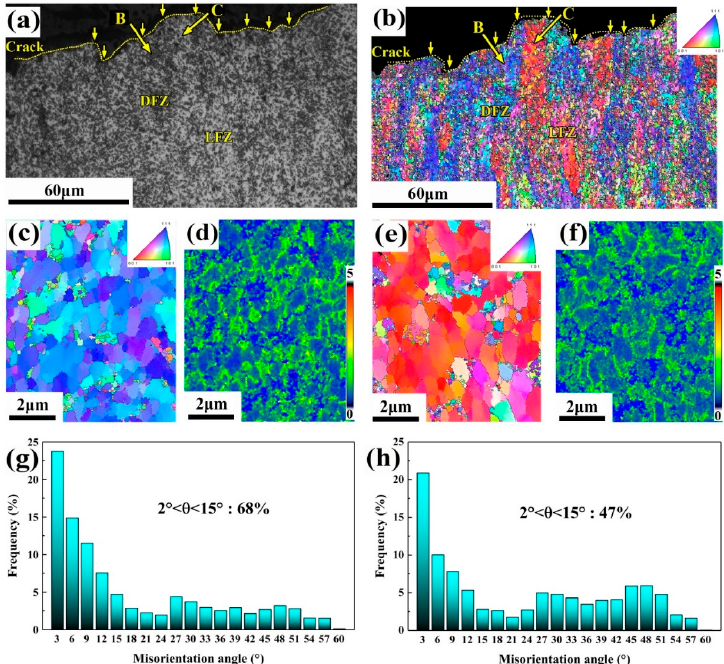
Figure 11. The OM and EBSD results of the selected region: ( a ) the OM image; ( b ) the IPF image; the detailed IPF at ( c ) regions B and ( e ) region C; the detailed KAM image at ( d ) region B and ( f ) region C; the distribution of misorientation angle of ( g ) region B and ( h ) region C.